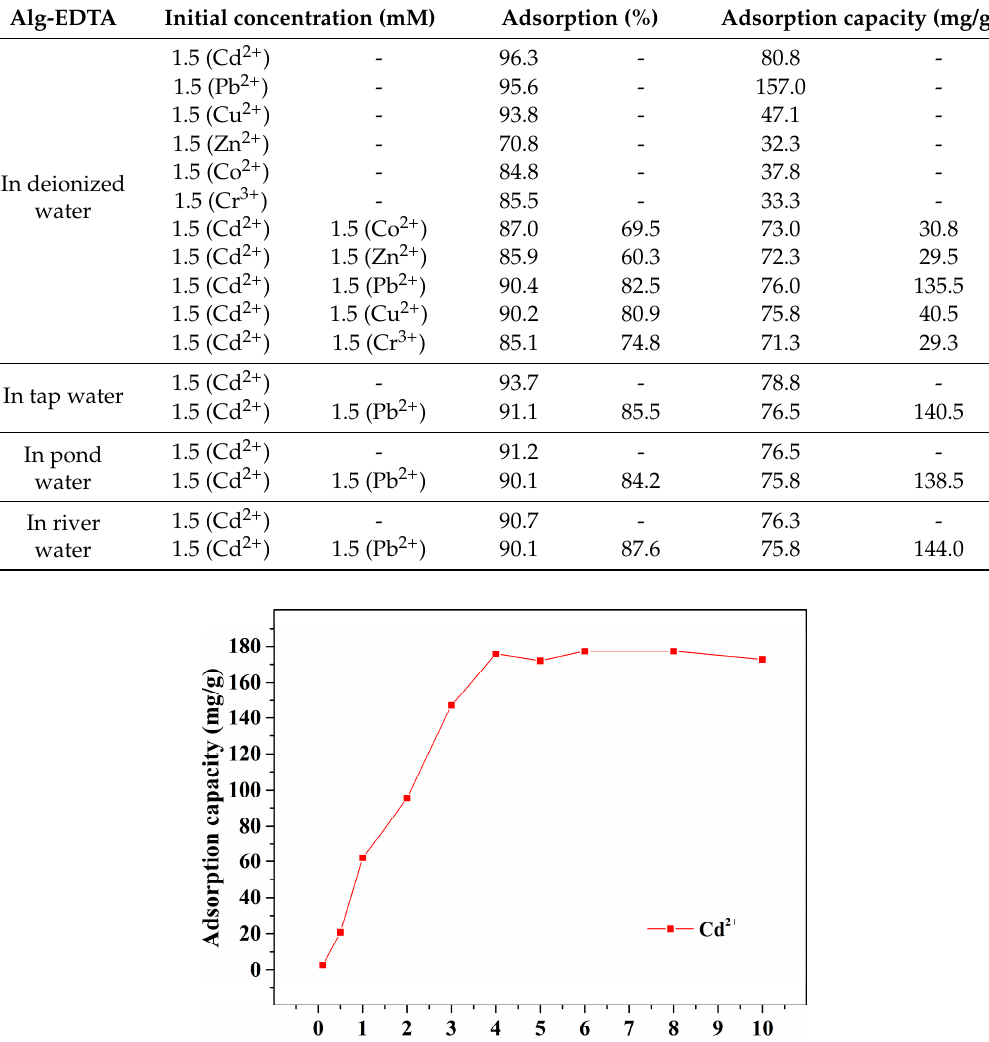
Table 3. The adsorption capacity of Alg-EDTA for heavy metal ions.